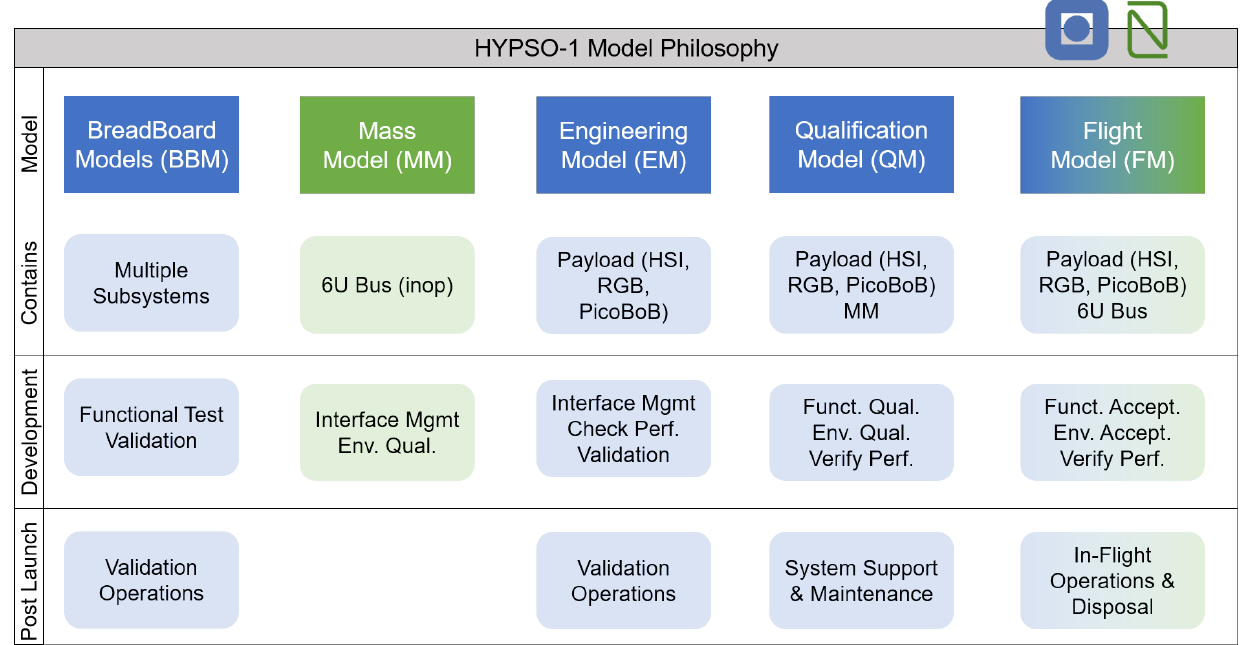
Figure 2. The HYPSO-1 model philosophy with both NTNU (blue) and NanoAvionics (green) deliver- ables. The payload contains the Hyperspectral Imager (HSI), Red-Green-Blue camera (RGB), and elec- tronics stack/computer/Break-out Board (PicoBoB). The Mass Model (MM) is a non-operational, hence “inop”, version of the 6U bus with the correct distribution of component masses. Abbreviations are as follows: Mgmt = Management, Perf. = Performance, Funct. = Functional, Qual. = Qualification, Env. = Environmental, Accept. =